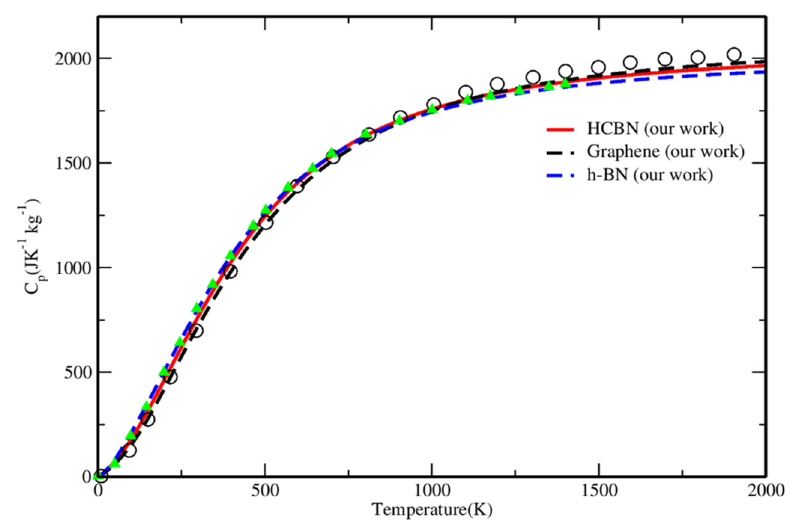
Figure 8. Specific heat capacities constant pressure (C p ) of graphene (black dashed curve), h-BN (blue dashed curve), and HCBN (red curve) compared with the results of References [65] (black circles) and [66] (green triangles).